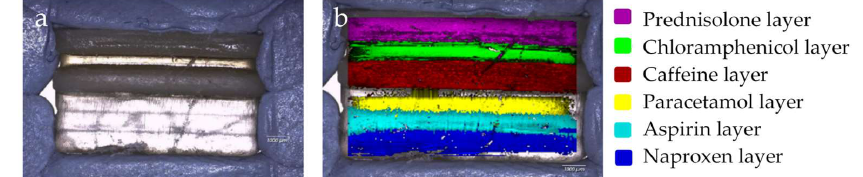
Figure 3. Visual imaging of a Type I polypill, using ( a ) optical light microscopy and ( b ) Raman mapping. The images show the spatial separation of layers.